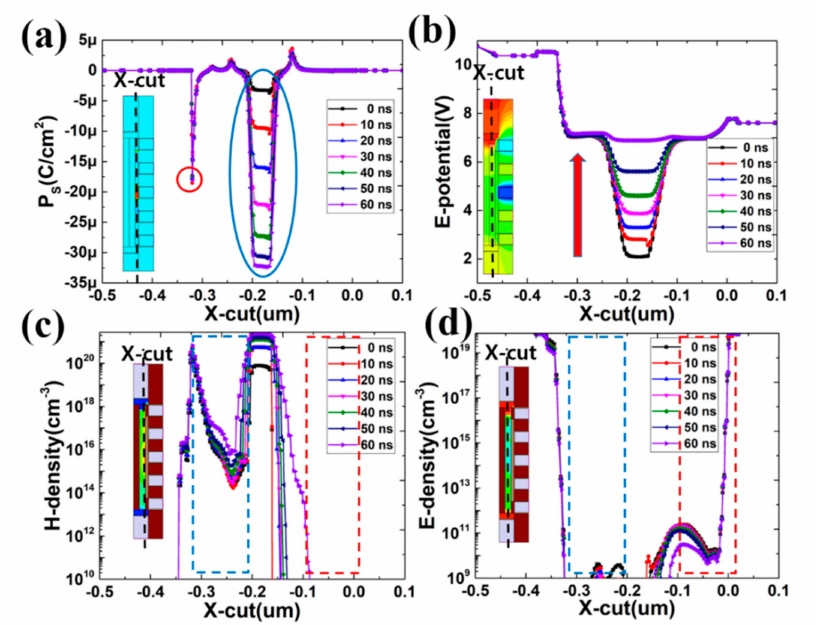
Figure 7. Various electrical changes that cause a change in the threshold voltage in the program operation: ( a ) change in the amount of minuscule, ( b ) potential in the channel, ( c ) hole density in the channel, and ( d ) electron density in the